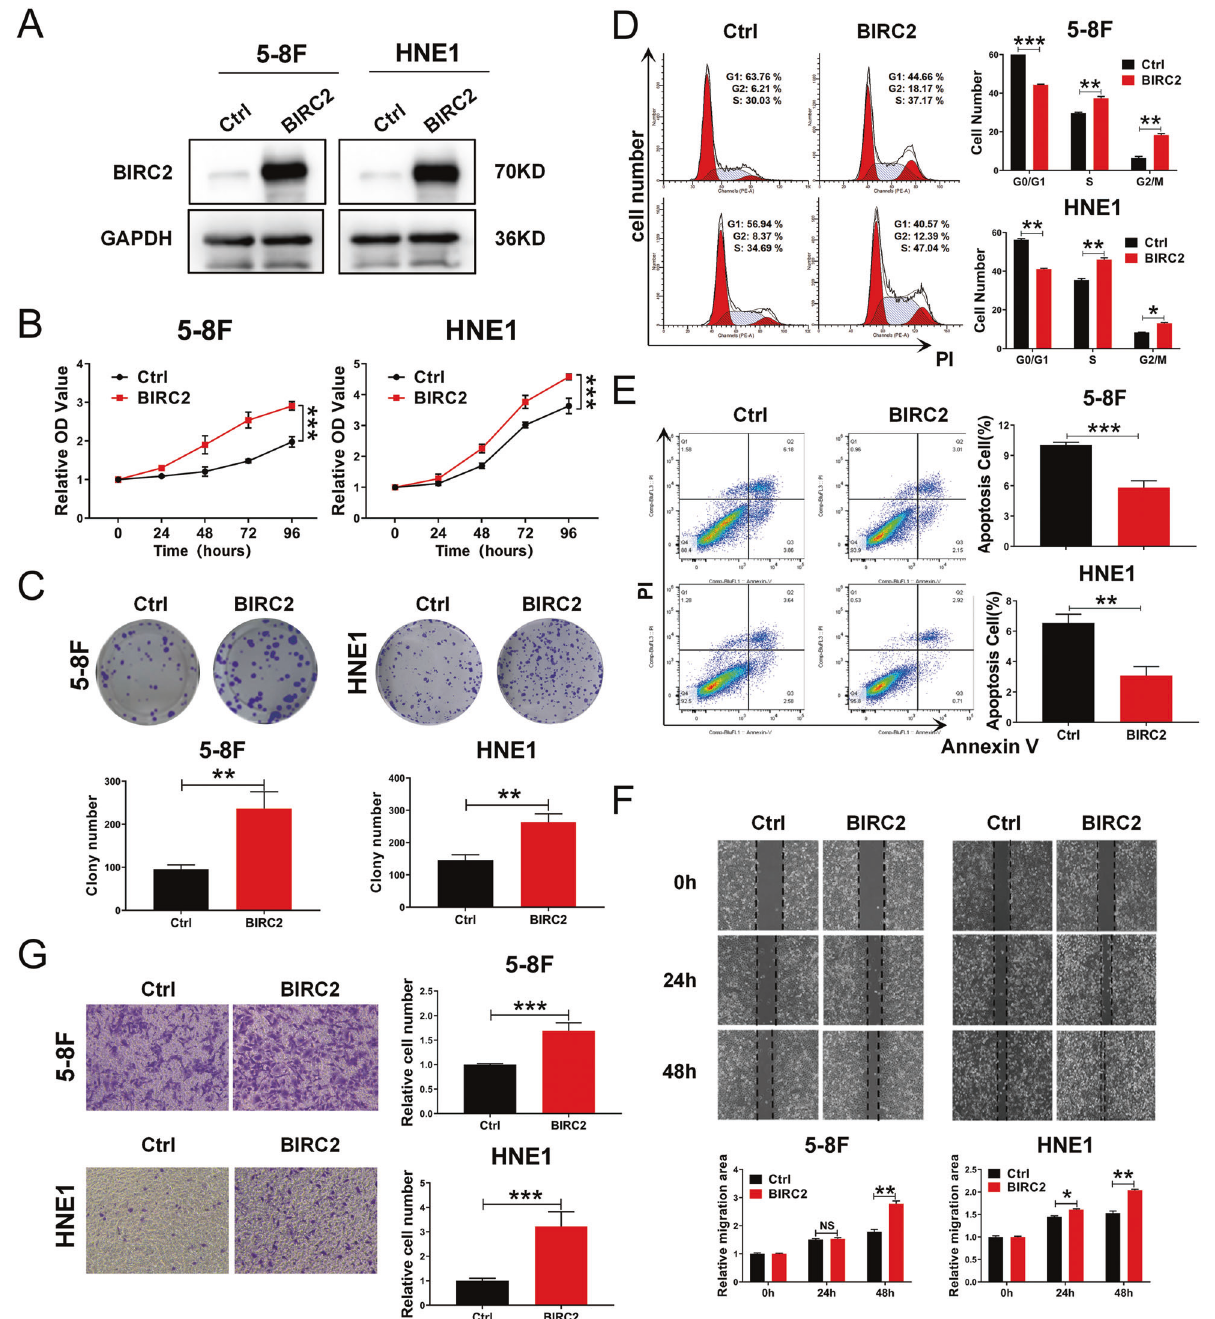
performed to detect the cell viability of 5-8 F and HNE1 cells with stable overexpression of BIRC2. C Colony-forming assay was used to detect the cell growth of 5-8 F and HNE1 cells with stable overexpression of BIRC2. D Flow cytometry analysis of cell cycle distribution, and the representative (left) and statistical results (right) were shown. E Flow cytometry analysis of cell apoptosis via Annexin V-FITC and PI double staining, and the representative (left) and statistical results (right) were shown. F Scratch wound healing analysis of cell migration in 5-8 F and HNE1 cells stably transfected with BIRC2 expression plasmid or control. G Matrigel invasion analysis of cell invasive capabilities in 5-8 F and HNE1 cells stably transfected with BIRC2 expression plasmid or control. Error bars represent the mean ± SD. *P < 0.05, **P < 0.01, ***P < 0.001; NS, no signi fi cance. All experiments were performed in